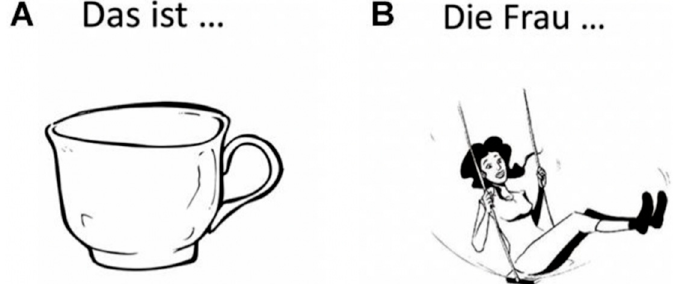
Figure 1. Example of a noun ( A ): Das ist … eine Tasse: ‘this is … a cup’) and a verb ( B ): Die Frau … schaukelt: ‘the woman … swings’) item of the VAN-POP 1 (artwork: Victor Xandri Antolin; ©University of Groningen).